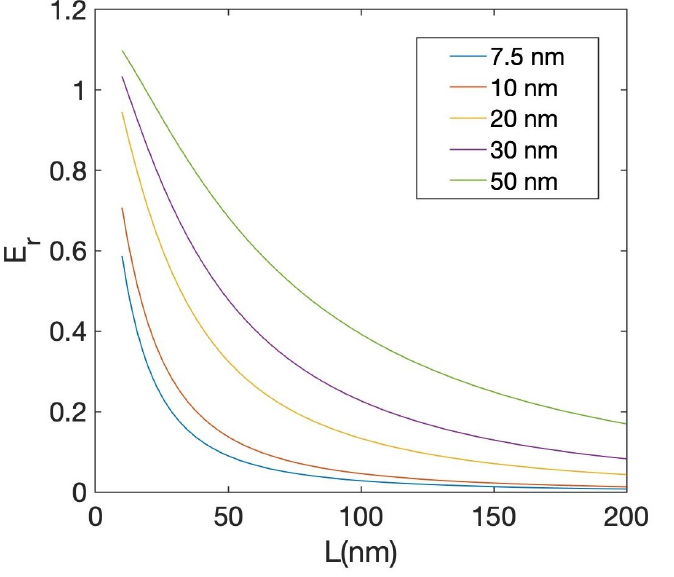
Figure 2. The variation of E r as a function of the separation, L , of the two plates for different values of the thickness c of each as indicated, and a = b = 2000 nm. Even for large enough values of c , the energy ratio is less than